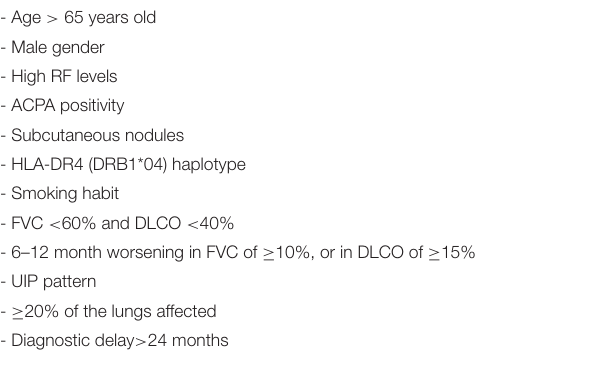
TABLE 1 | Predictors of Interstitial Lung Disease (ILD) development and severity in RA